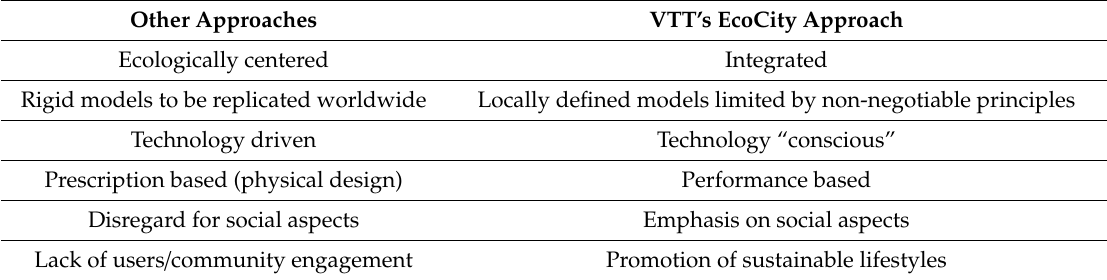
Table 2. Comparison between VTT’s EcoCities and other approaches (Carmen Antuña-Rozado,